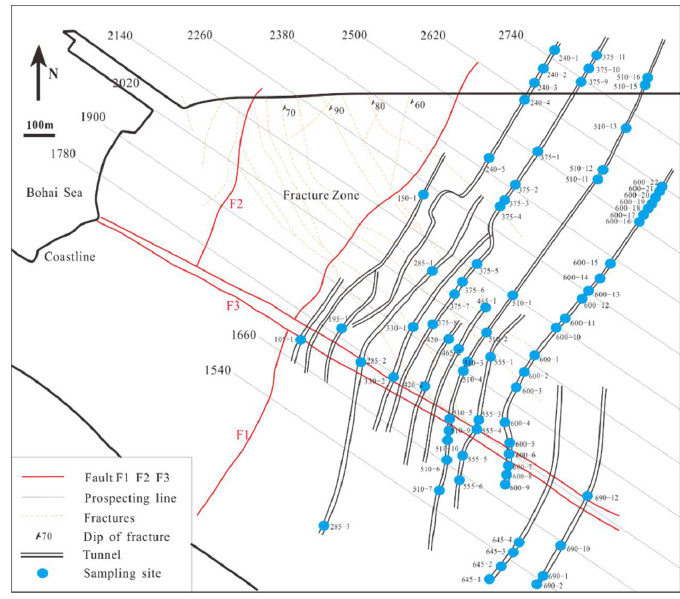
Figure 2. Location of water samples.